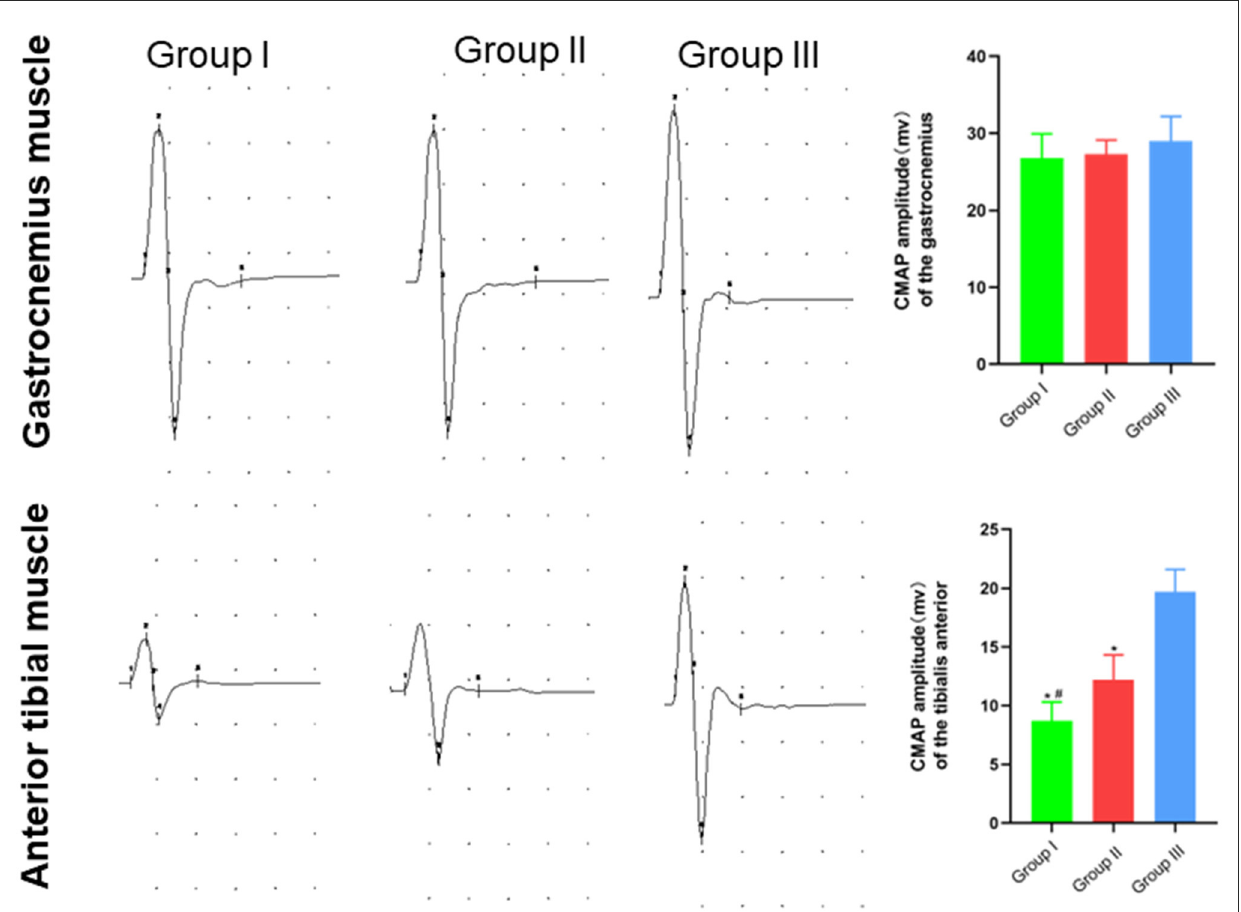
FIGURE4 Waveform and amplitude of the compound action potential of gastrocnemius and tibialis anterior muscles detected by electrophysiology. In Group I, only the distal end of the common peroneal nerve was fostered; in Group II, both proximal and distal ends of the common peroneal nerves were fostered; Group III was sham operated normal group. Data are expressed as mean ± SD ( n = 6 in Group I, 6 in Group II and 6 in Group III). * P < 0.05, vs. Group III; # P < 0.05, vs. Group II.